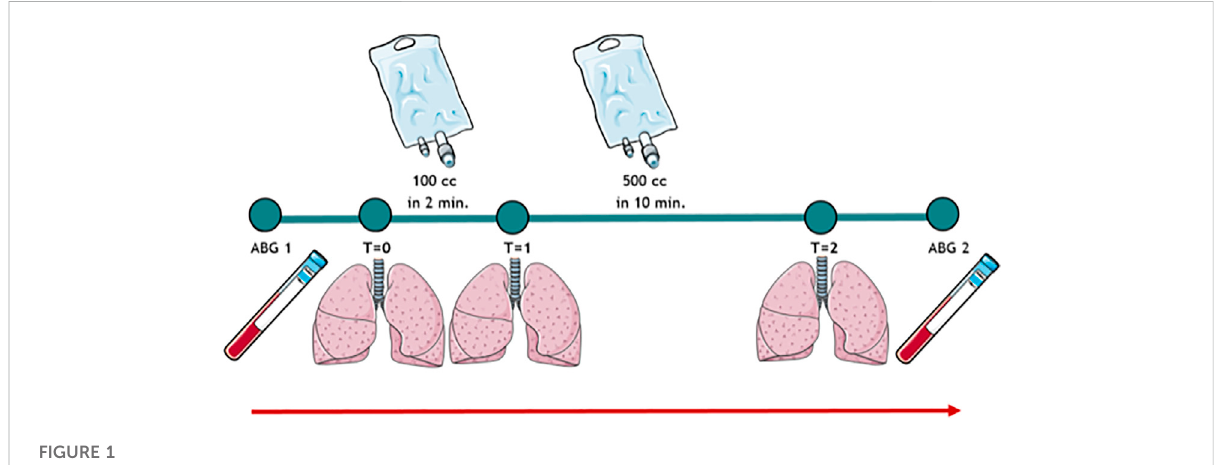
FIGURE 1 Visual study protocol. ABG, arterial blood